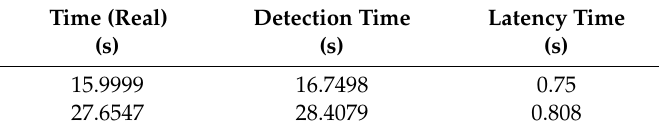
Table 1. Performance of the anomaly detection algorithm.